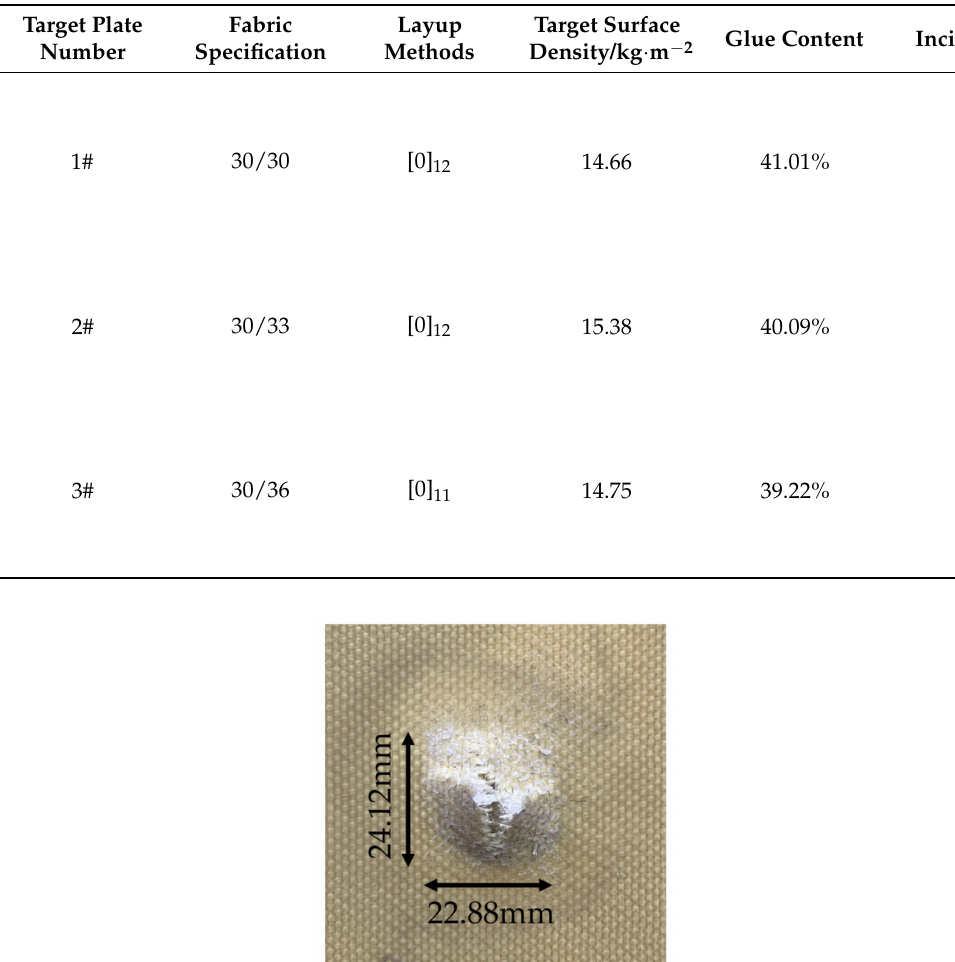
Table 3. Ballistic test results of 3D armor materials with different weft densities.